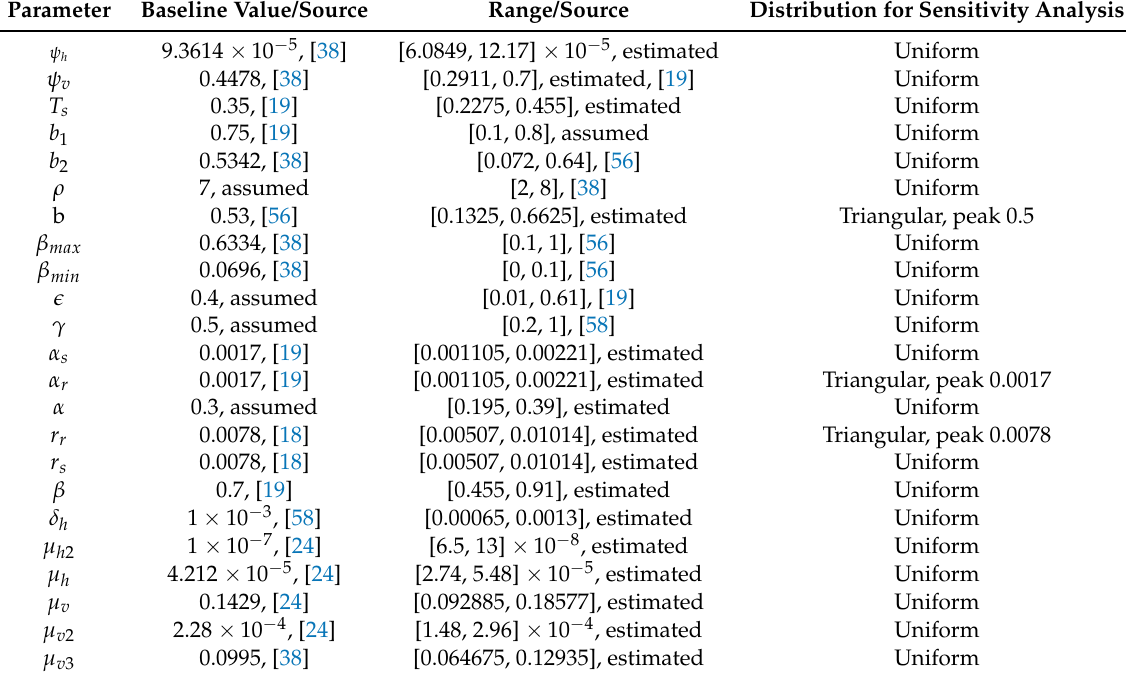
Table 3. Parameters, their baseline values, ranges, and distribution type for sensitivity